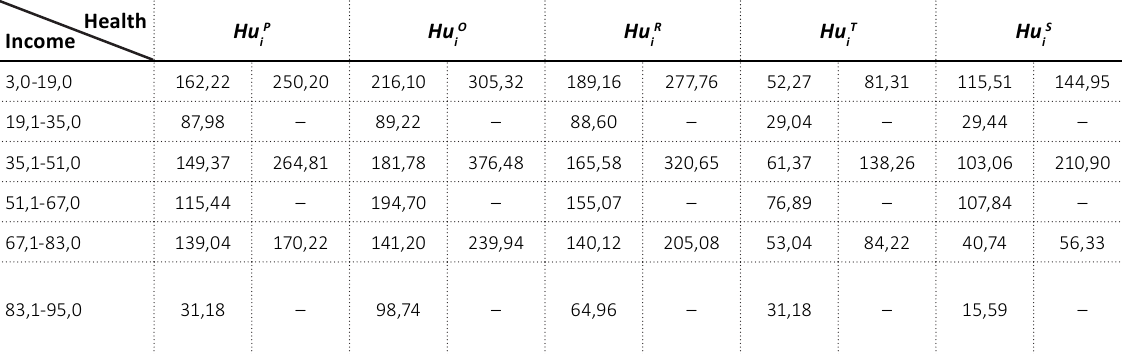
Table 6. Risk matrix: Bayes-Laplace’s risk criterion and Savage’s criterion Health